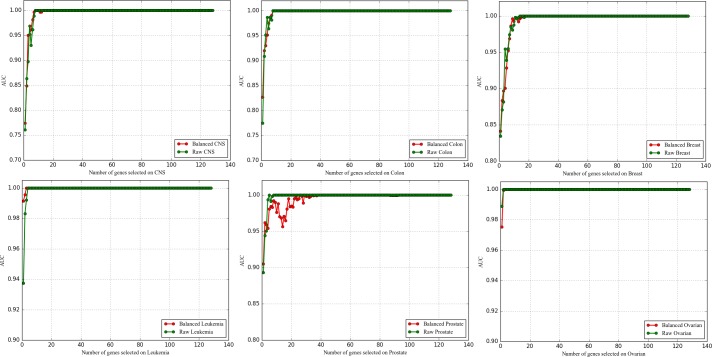
The comparison of AUC obtained on six balanced and raw datasets.